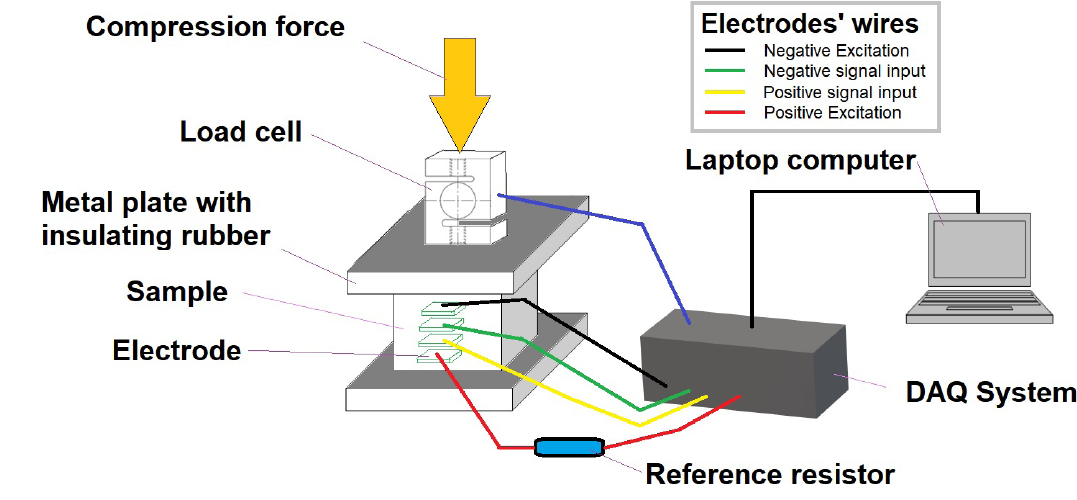
Figure 6. Data acquisition scheme of the experiment.